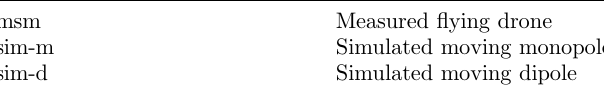
Figure 7. Reconstructed trajectory of the drone fl ight with velocities. Red dots represent microphone positions. The moving coordinate system is indicated at three instants in time (start, array passing, end). The yellow frame indicates the 3D focus area (i.e. the monitored fl ight corridor) evaluated for recovering the trajectory from the microphone array. Table 4. Abbreviations of the three datasets.